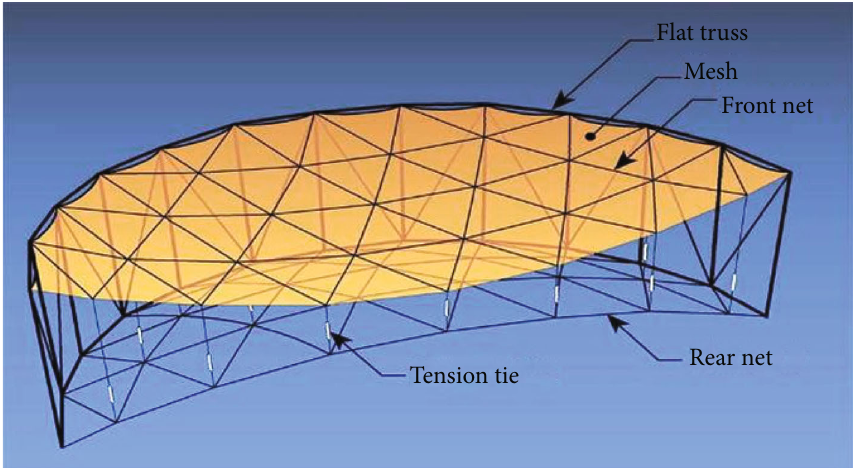
Figure 1: A typical DMR with deployed working surface.